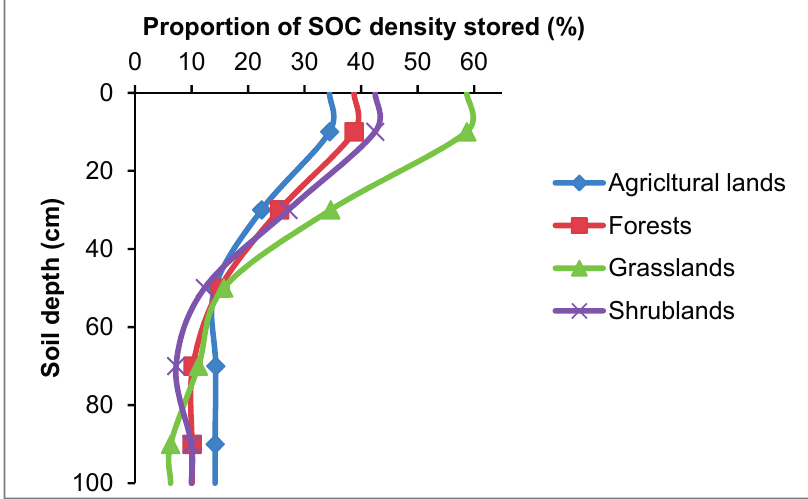
Figure 2. Proportion of SOC density (kg·m − 2 ) stored at different depth intervals under different LULC types. Data are in percentages and are plotted at the midpoint of each depth